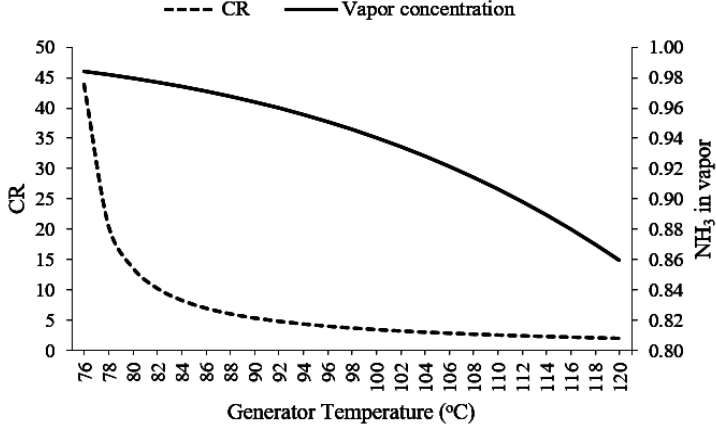
Figure 8. Variation of NH 3 vapor concentration and CR with T gen .